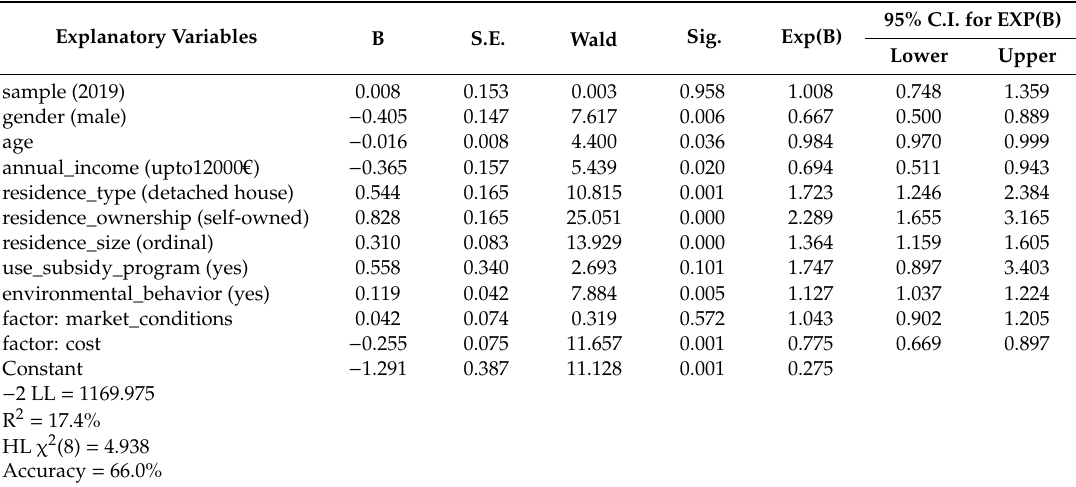
Table 5. Logistic regression model on real decisions on the installation of residential microgeneration technologies–pooled data (2012 &